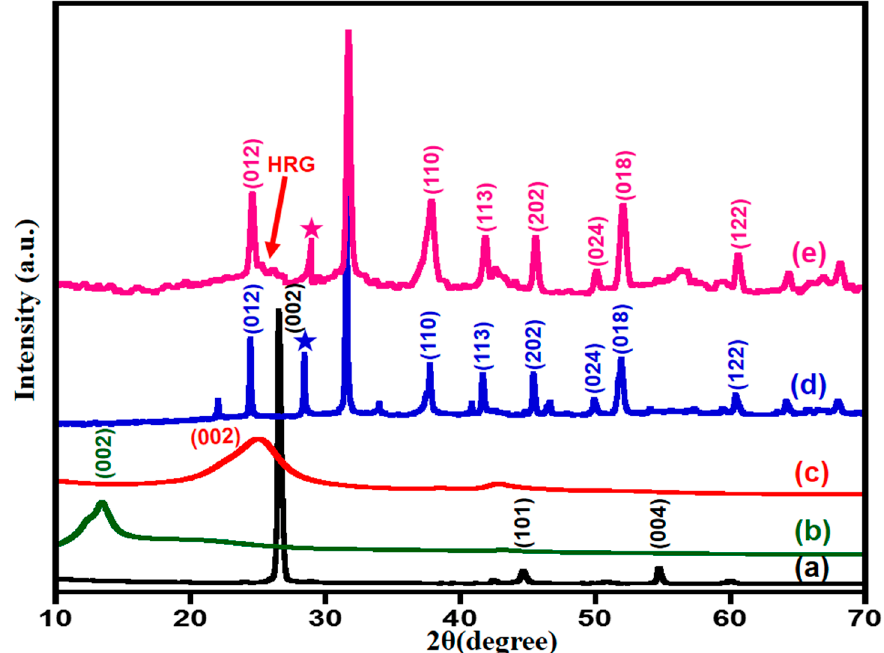
Figure 1. XRD patterns of ( a ) pristine graphite; ( b ) GO; ( c ) HRG; ( d ) ZnO x (1%)–MnCO 3 ; and ( e ) ZnO x (1%)–MnCO 3 /(1%)HRG. The reflections marked with an asterisk (*) could be attributed to the presence of ZnO x